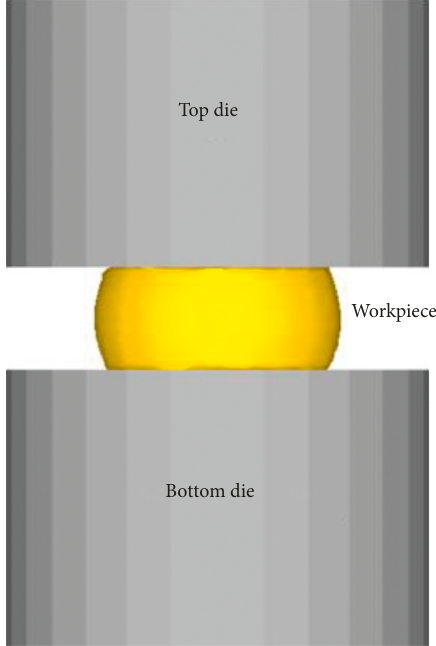
Figure 5: Material deformation diagram at plastic